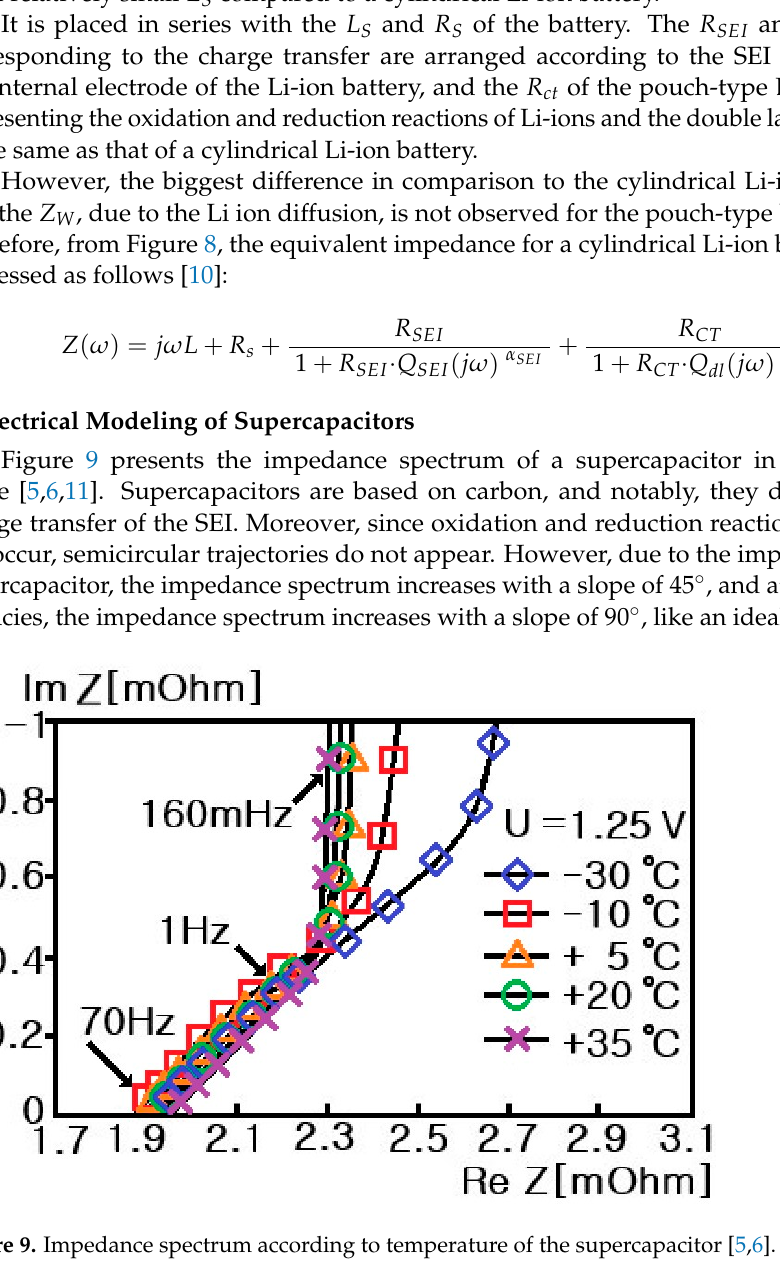
Figure 8. Electrical equivalent circuit of pouch-type Li-ion battery.